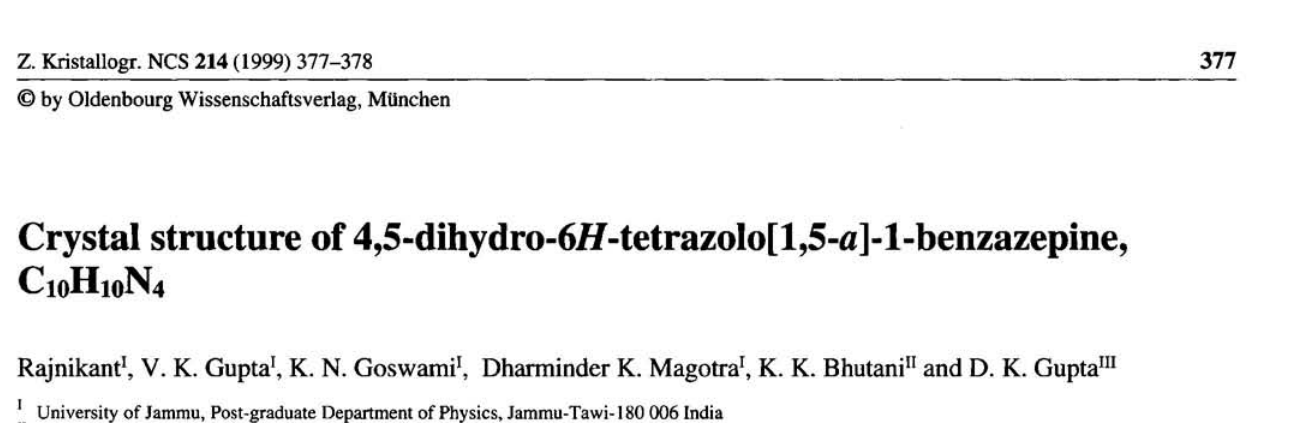
Table 1. Data collection and handling.